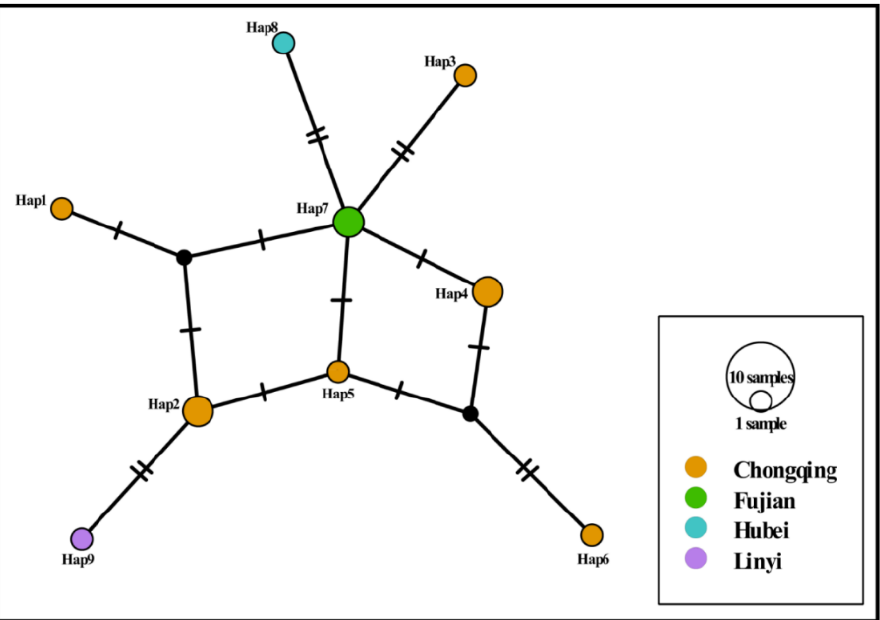
Figure 3. TCS haplotype network of B. gibsoni isolates in cats in China. The different coloured dots